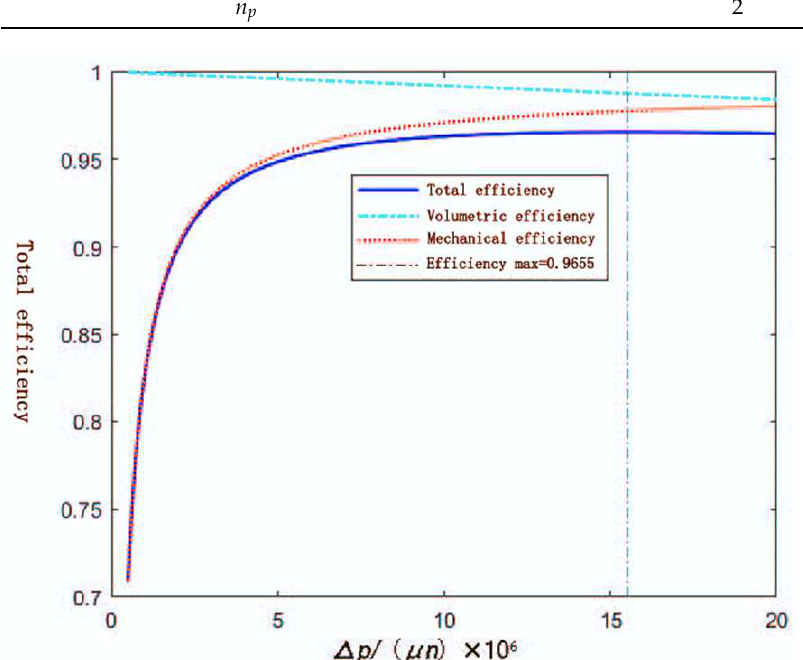
Figure 5. Dimensionless efficiency curve of axial piston pump.